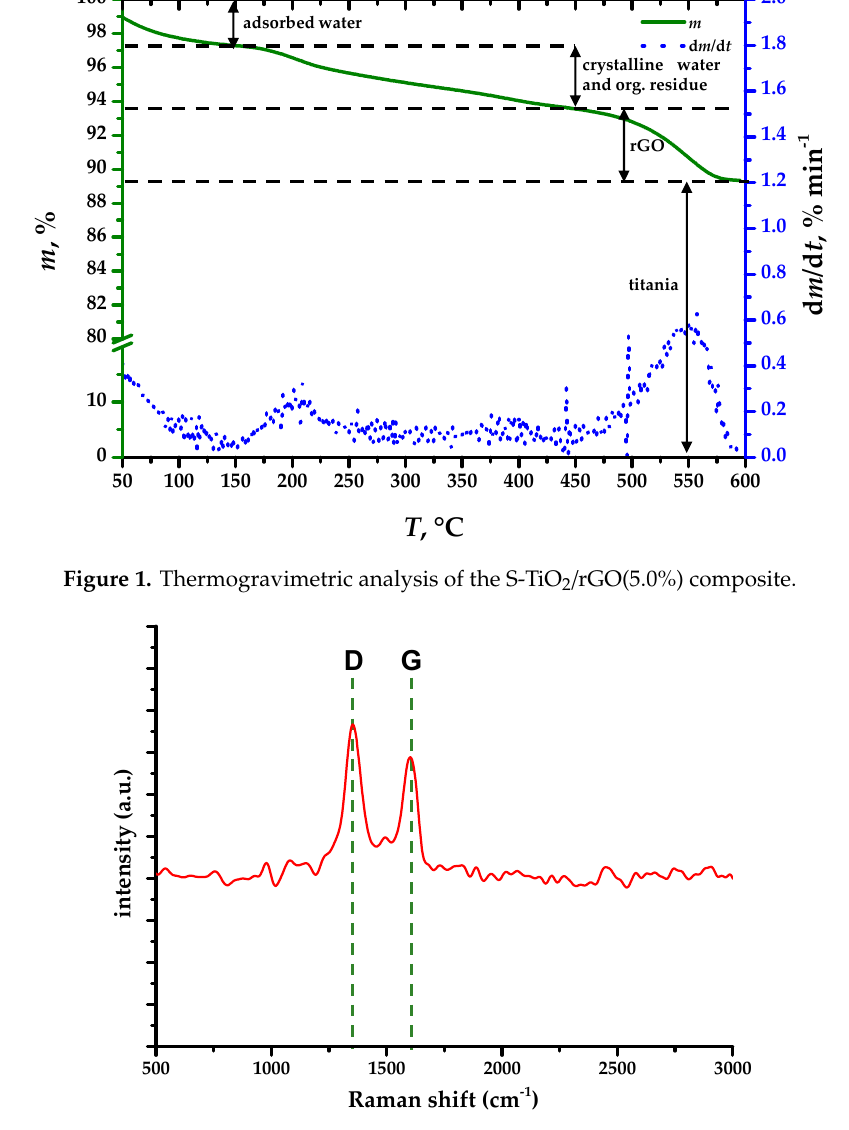
Figure 2. Raman spectrum of S-TiO 2 /rGO(5.0%) composite.